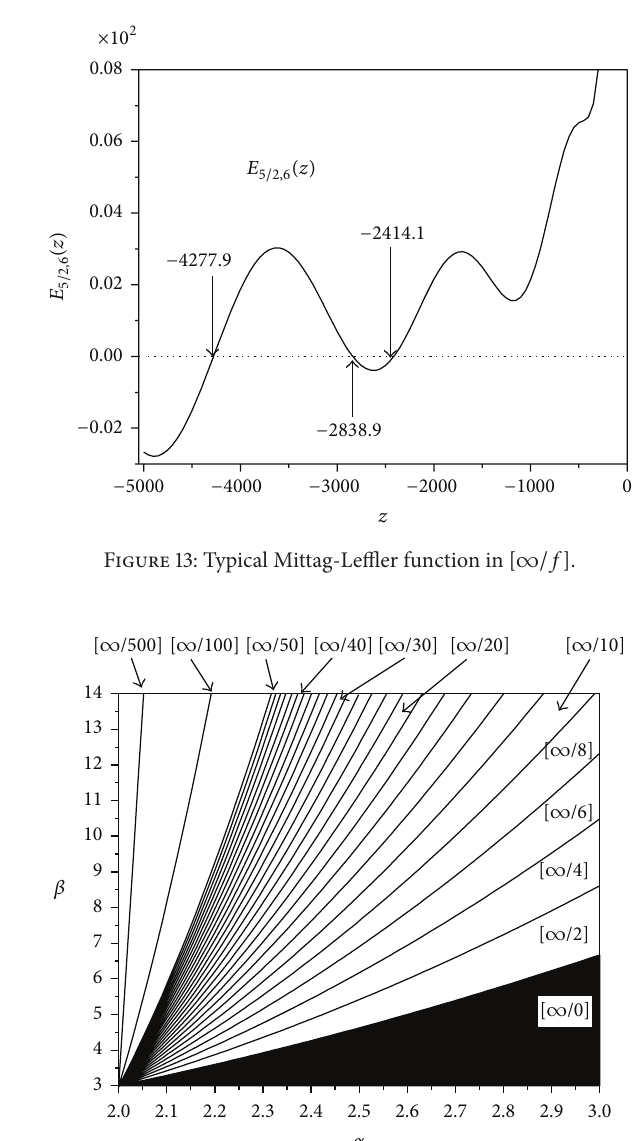
Figure 14: Phase [ ∞/𝑓 ] in detail showing subphases [ ∞/𝑛 ], 𝑛 = 2, 4, 6,. . . .